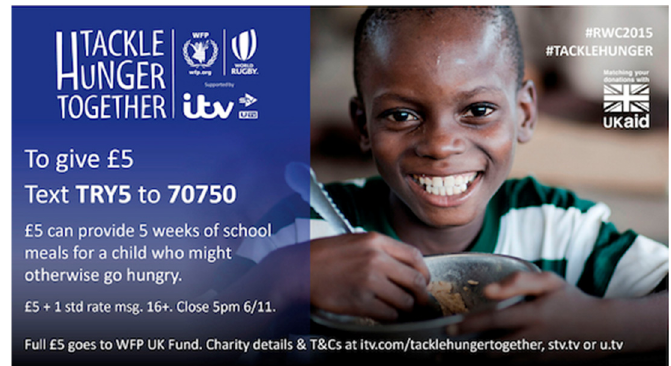
Figure 2. UK Funding Appeal for 2015